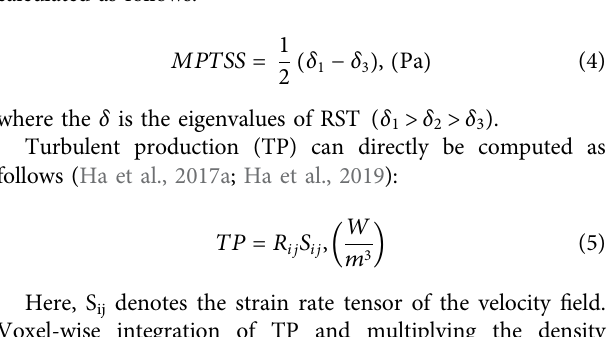
FIGURE2| Representativevelocity mappingofICOSA64D fl owMRI for in-vivo